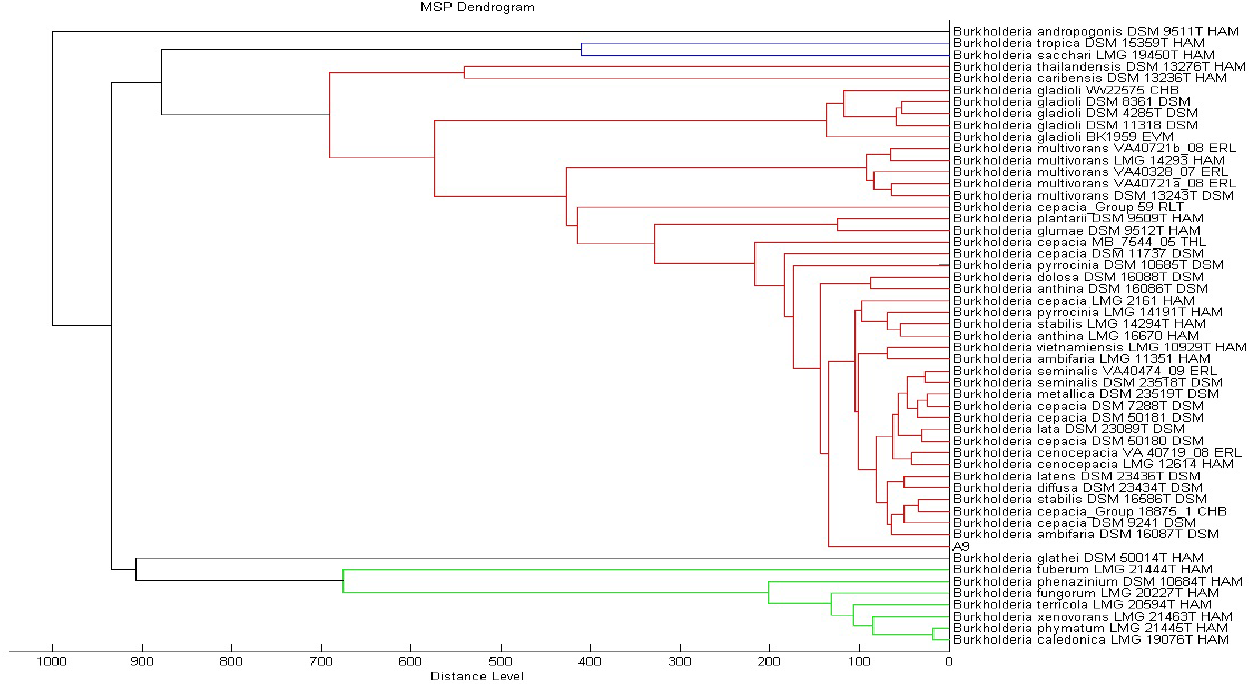
Figure 1. Phylogenetic dendrogram of strain A9 constructed by the standard